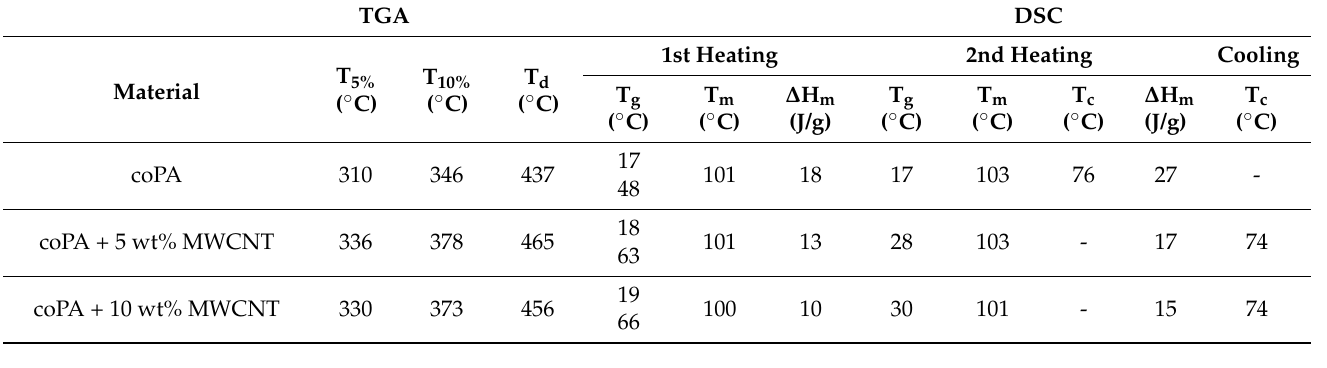
Table 2. The results of thermal analysis.